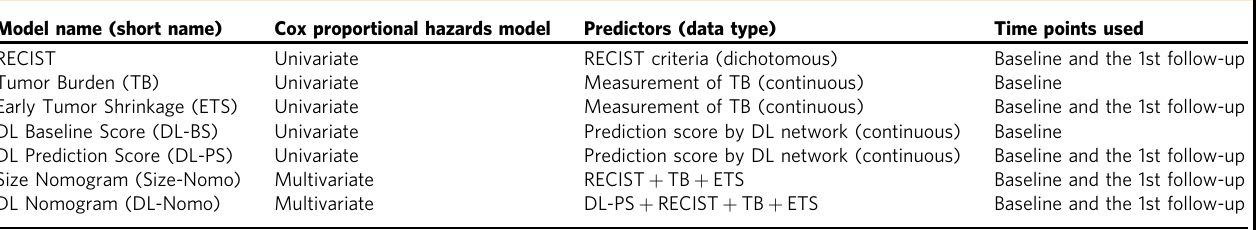
Note: ‘ + ’ In the table indicates combination of